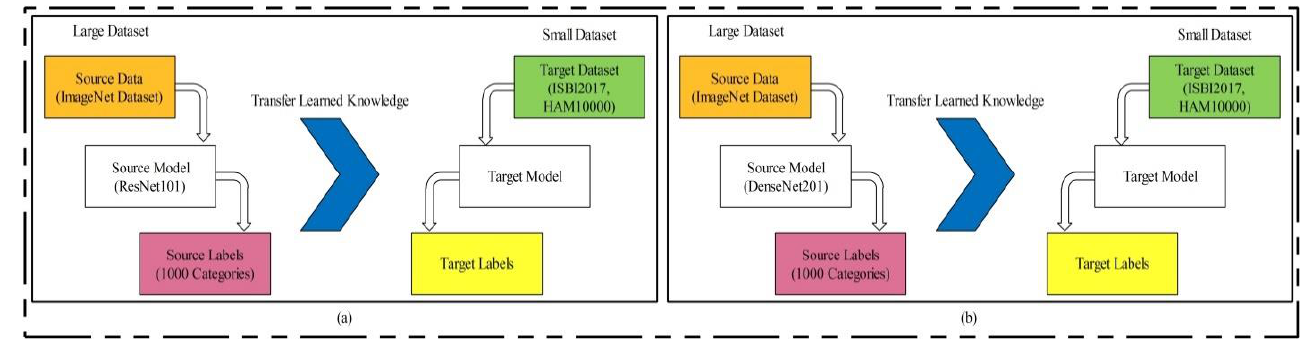
Figure 14. Transfer learning concept for reusing a model for feature extraction: ( a ) using ResNet101 model, ( b ) using DenseNet201 model.